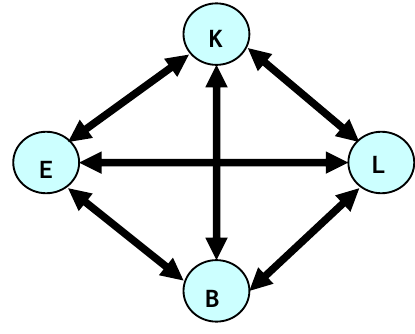
Figure 5. Infrared sensors in each room (E: entrance, K: kitchen, L: living room, B: bathroom) have a probabilistic relation identical to a transition diagram of the Markov model. Each state indicated by a node means the sensor in the room is activated.